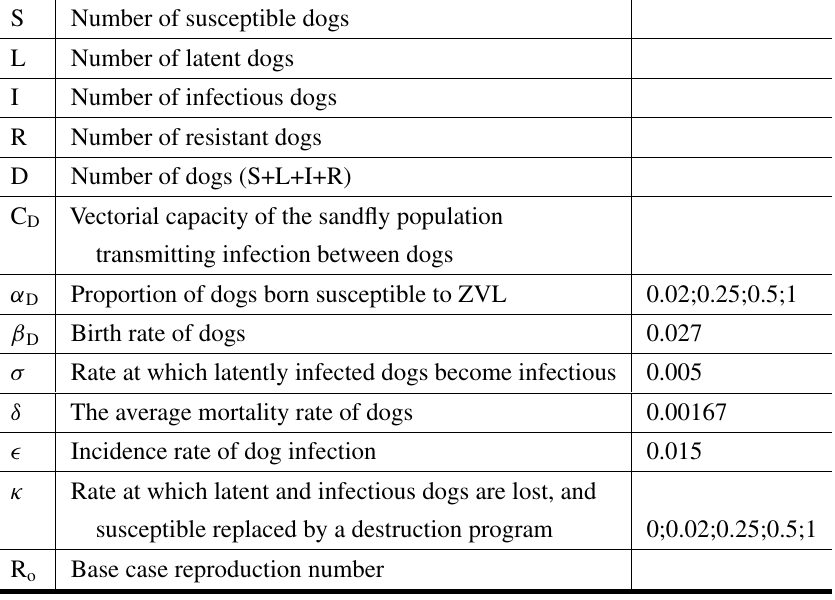
Definition of variables and parameters used in the Model of ZVL.